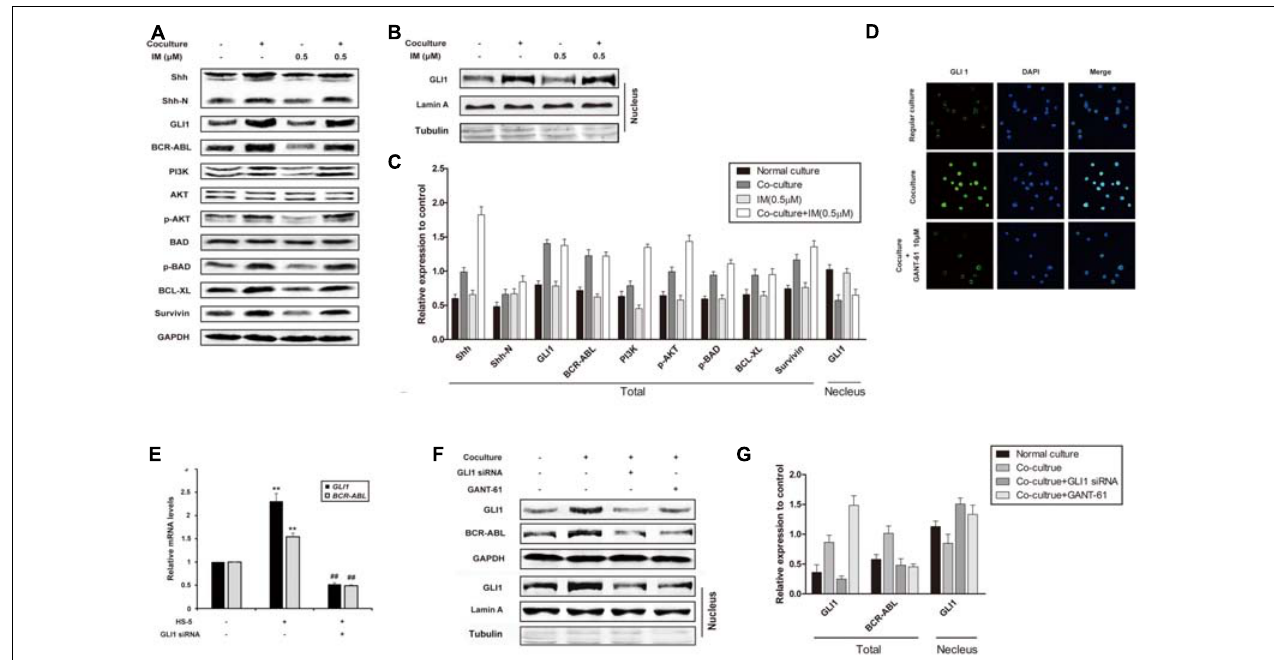
FIGURE 2 | Cell co-culture up-regulated BCR-ABL via activating hedgehog pathway. (A) Regular cultured and co-cultured K562 cells were maintained for 24 h followed by treatment with IM for another 36 h. The lysates were subjected to western blot analysis using antibodies against Shh, Shh-N, GLI1, BCR-ABL and its downstream proteins as indicated. (B) Cells were cultured and treated as described above. Nuclear proteins were isolated and subjected western blot analysis using GLI1 antibody. Lamin A and Tubulin protein expression was set as nuclear and cytoplasmic marker, respectively. (C) The protein level was quantified and the data represented mean ± SD of three independent experiments. (D) K562 cells were cultured alone or co-cultured with HS-5 cells for 24 h, then treated with GANT-61 for 24 h. Immunofluorescence was performed with GLI1 antibody. DAPI was used to stain nuclei. (E) Control and Specific siRNA against GLI1 was transfected into regular cultured and co-cultured K562 cells as described in Section “Materials and Methods.” Total RNA was isolated and 1 µ g RNA was subjected to quantitative real-time reverse transcription-PCR for analysis of GLI1 and BCR-ABL mRNA levels. Fold changes were normalized to GAPDH, and represented as mean ± SD of three replicates. (F,G) Cells were treated with GANT-61 and GLI1 siRNA as described in (D,E) . Western blot analysis was carried out to analyze the expression of GLI1 and BCR-ABL. ( ## p < 0.01 compared with adjacent group and ∗∗ p < 0.01 compared with regular